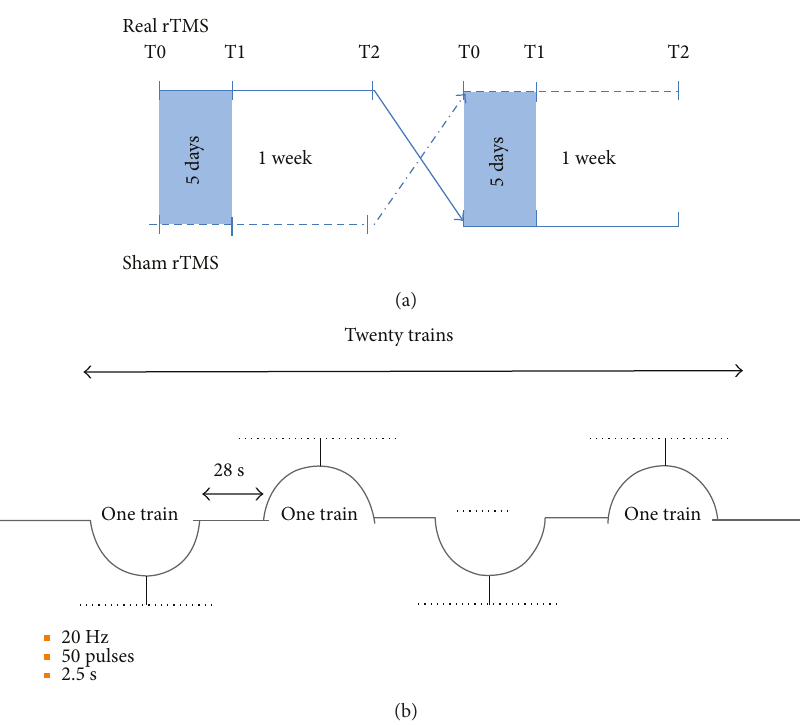
Figure 1: rTMS protocol for the patients. (a) The study design. All patients received active 20 Hz rTMS and sham stimulation for 5 consecutive days over the left primary motor cortex (M1), in separate sessions spaced one week. Clinical evaluation and EEG data were assessed at the baseline (T0), immediately after the end of the 5 days of treatment (T1) and 1 week after the treatment (T2). (b) rTMS procedure. A session of 1000 pulses were delivered in 20 trains. Each stimulation train lasted 2.5s with a 28s intertrain Table 2: DOC subjects ’ data at the CRS-R score.